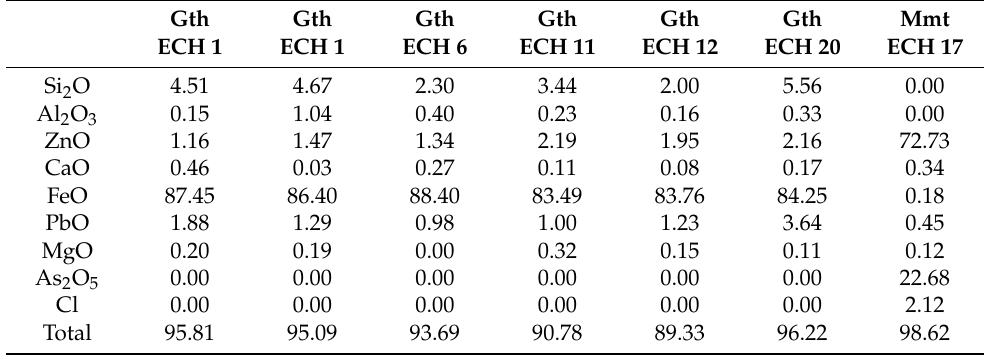
Table 4. Chemical composition of selected goethites (Gth) from the nonsulfide ore.